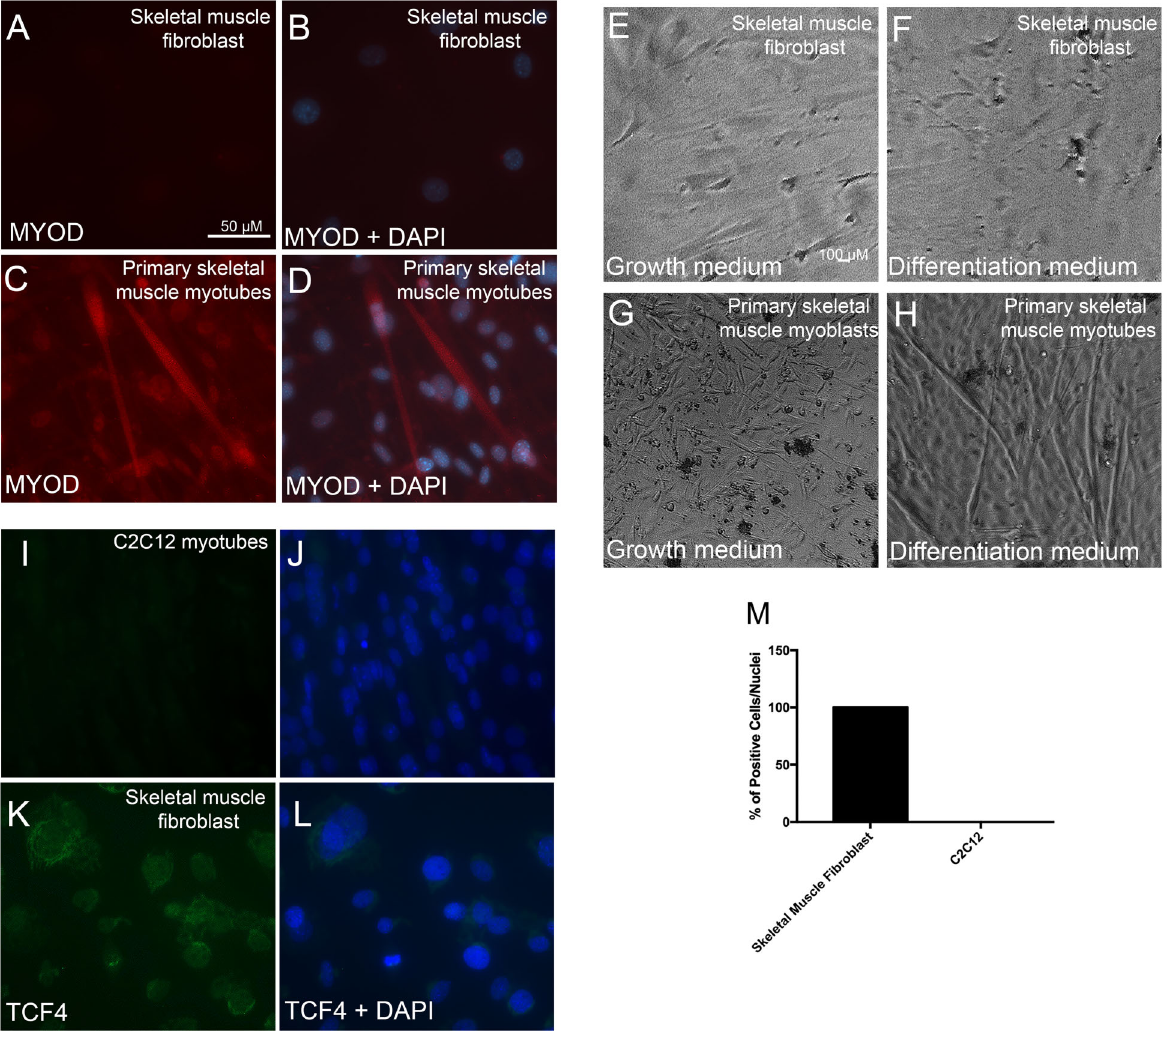
Figure 1. Validation of fi broblast culture. Immuno fl uorescence for MyoD in skeletal muscle fi broblasts ( A , B ) and primary skeletal muscle myotubes as a positive control for MyoD labelling ( C , D ) 2 days after differentiation medium (2% HS). Phase contrast microscope image from skeletal muscle fi broblasts submitted to either growth medium with 80 – 90% con fl uence ( E ) or differentiation medium for 2 days ( F ). Myoblasts were also submitted to either growth medium with 80 – 90% con fl uence ( G ) or differentiation medium for 2 days ( H ) as a positive control. Immuno fl uorescence for TCF4 in C2C12 myotubes differentiated for 2 days ( I and J ) and in skeletal muscle fi broblasts ( K and L ). M : Percentage of TCF4-positive cells. Images were taken at high ( A – D and I – L , 400 (cid:1) ; bar, 50 m M) and low ( E – H , 40 (cid:1) ; bar, 100 m M) magni fi